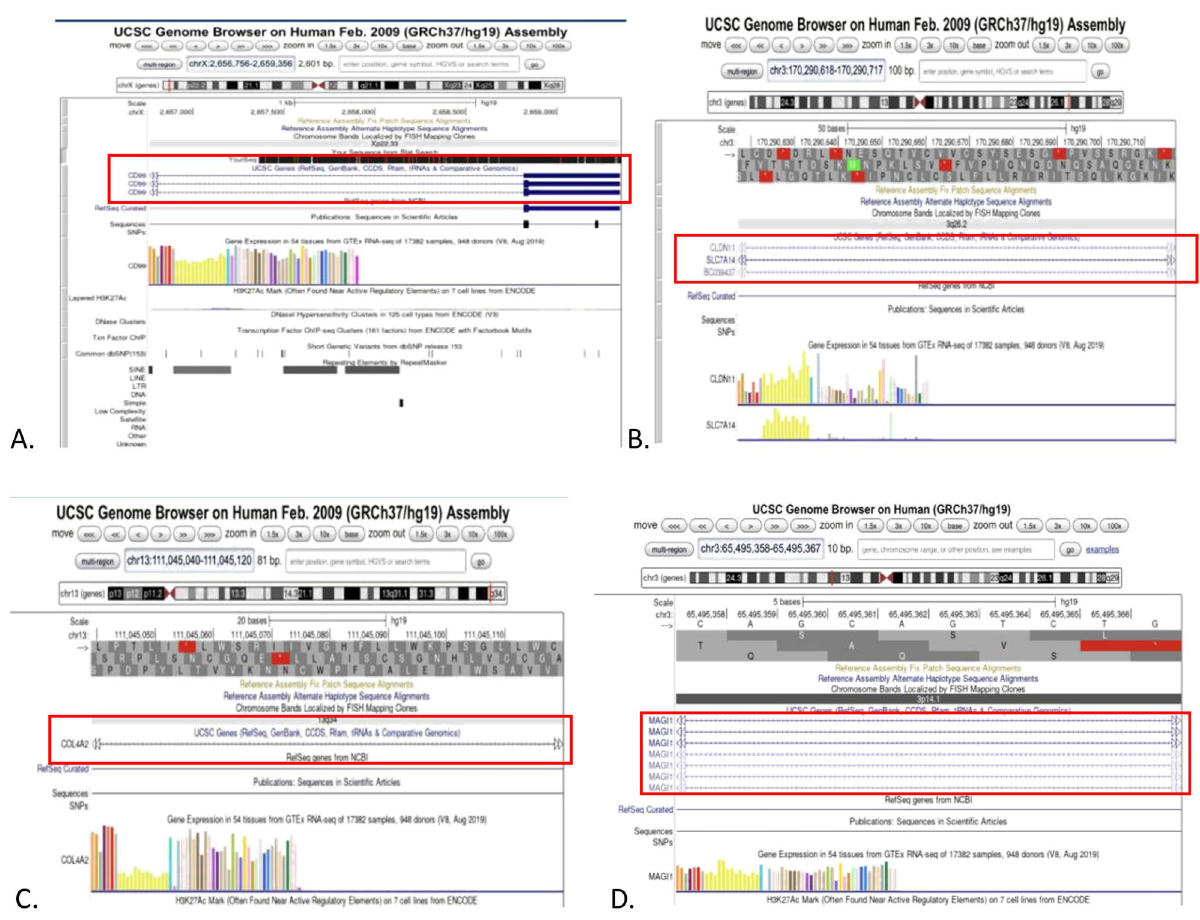
Figure 2. The balanced translocation carrier sequencing results DNA fragments were compared to the reference human genome ( GRCh37/hg19 ): ( A ) chrX:2653403–2657362 ( B ) chr3:170290668–170290678 ( C ) chr13: 111045080–111045082 ( D ) chr3: